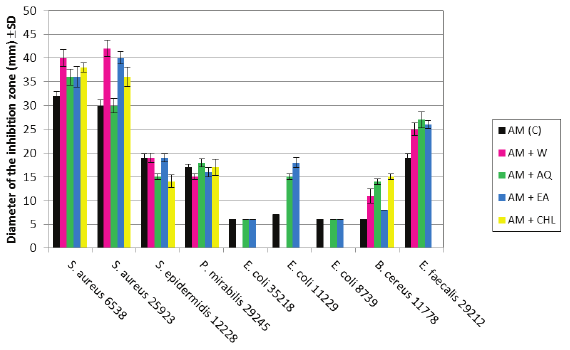
Figure 2: Bacterial strains response to Ampicillin/AM combinations with the four Arctii folium extracts (AM+W, AM+AQ, AM+EA, and AM+CHL) comparatively to the antibiotic alone, AM (C); diameter of the inhibition zone, (mm) ± SD.